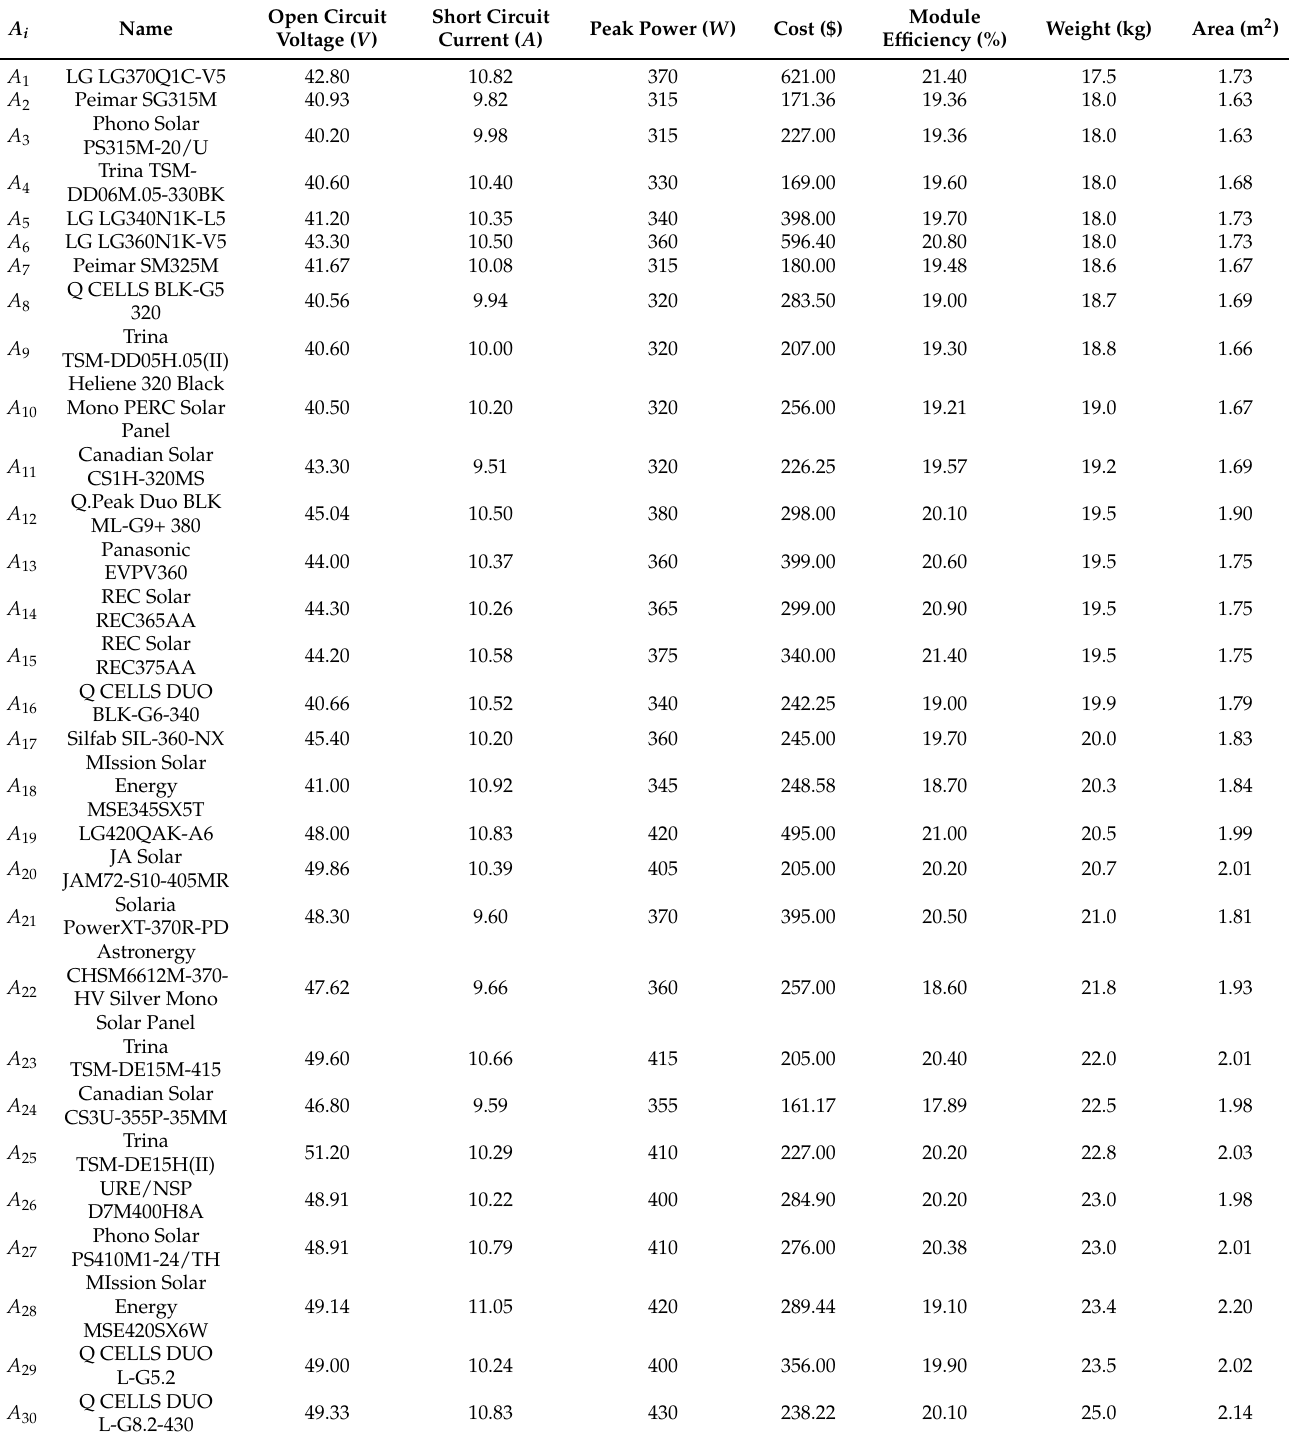
Table 2. Data on the evaluated alternatives obtained from